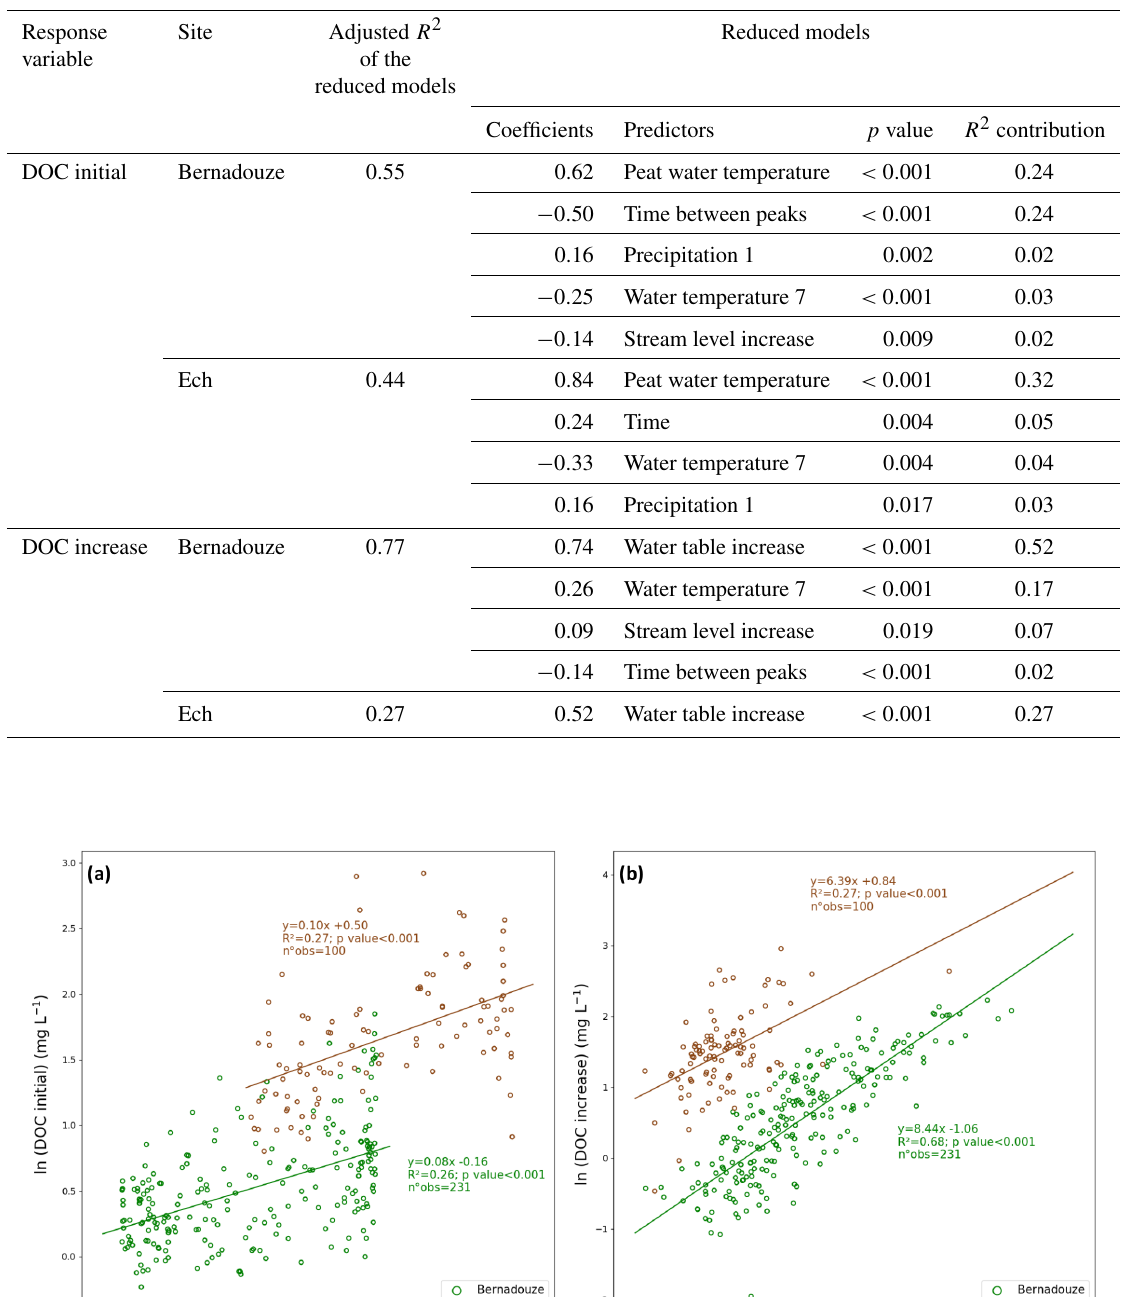
Table 3. Reduced models explaining DOC concentration during peak events (DOC_initial and DOC_increase) at the outlet of Bernadouze and Ech peatlands. Reduced models were obtained after a backward stepwise selection procedure applied on the full model (see details in Sect. 3.6). Adjusted R 2 values of each model are given as the predictors and their associated coefficient, p value and R 2 contribution.